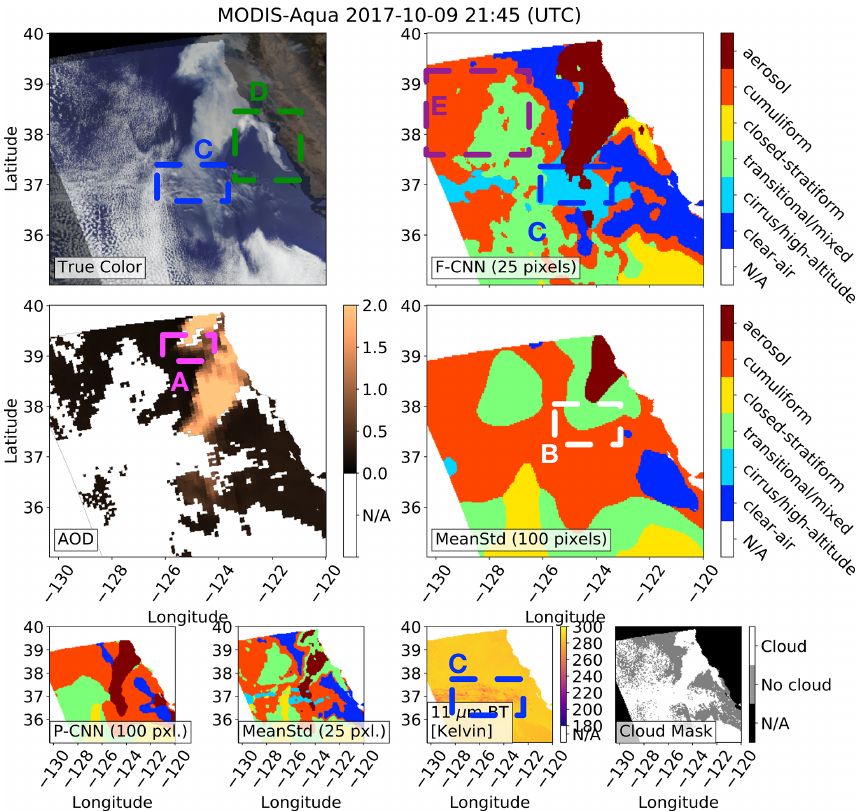
Figure 8. Box A shows where (1) the MODIS MYD04 aerosol product has aerosol optical depth (AOD) retrievals which are flagged as bad by the MYD04 quality control, (2) the MODIS MYD35 cloud-mask product labeled the aerosols as clouds, and (3) the pretrained 100-pixel CNN and fine-tuned 25-pixel CNN (F-CNN) methods were able to successfully detect the extreme aerosols. Box B shows where the baseline mean–standard deviation (MeanStd) method misclassified the aerosols as clouds. Box C shows the presence of sparse cirrus/high-altitude clouds with 11µm brightness temperatures (BTs) ranging between 249 and 257K and where the 25-pixel methods (F-CNN and MeanStd) were able to detect the cirrus/high-altitude cloud. Box D shows possible closed-stratiform clouds which are near the smoke plume that was detected by the F-CNN method. Box E shows where the F-CNN method separates cumuliform from transitional/mixed clouds. For all images any sun glint and landmasses have been masked